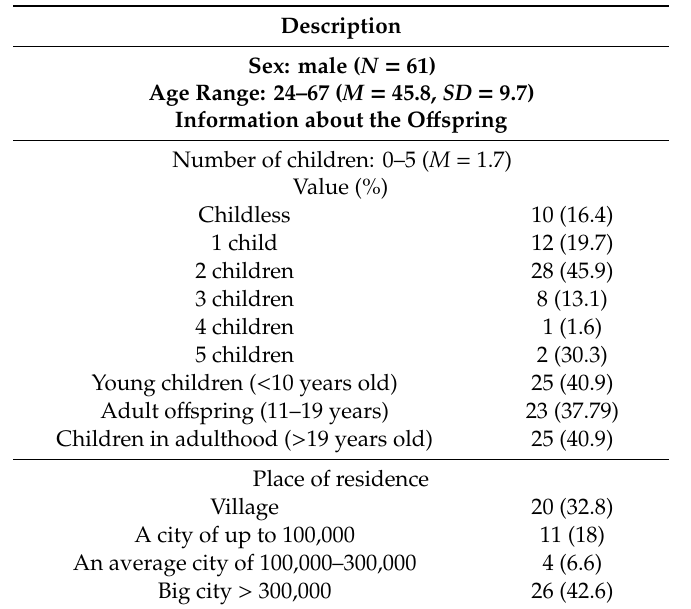
Table 1. Sociodemographic data of the male partners of the women with